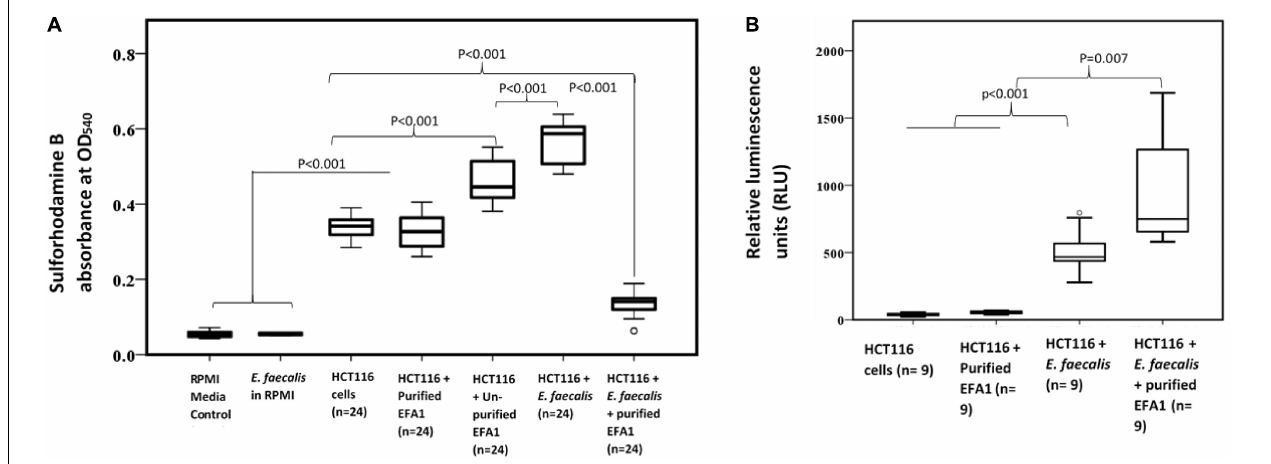
FIGURE 6 | Bacteriophage EFA modulates the effects of E. faecalis on HCT116 cancer cell line by increasing ROS production and attenuating cancer cell proliferation. (A) Cancer cell proliferation was significantly increased in E. faecalis co-cultured HCT116 cells compared to all other cultures. The RPMI growth media and E. faecalis growing in RPMI showed minimal SRB absorbance. HCT116 cells grown with purified bacteriophage EFA1, and the HCT116 cells grown on their own, had similar levels of proliferation. Treatment of the HCT116 cells/ E. faecalis co-culture with purified bacteriophage EFA1 resulted in significant reduction of cancer cell growth, to levels below those of the control HCT116 culture. (B) ROS production was significantly increased in the HCT116/ E. faecalis co-culture with purified EFA1, and to a lesser extent in the HCT116/ E. faecalis co-culture, compared to HCT116 cells on their own. There was no statistical difference in ROS production between untreated HCT116 and those grown with purified bacteriophage